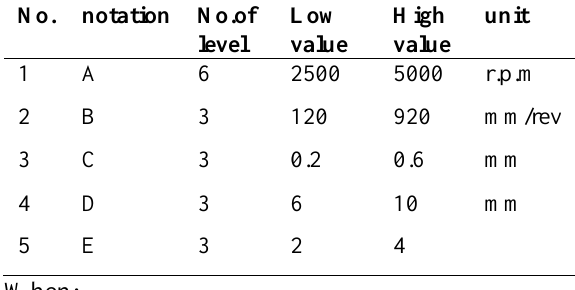
When: A: spindle Speed, B: feed rate, c: depth of cut D: diameter of cutter, E: number of flutes The roughness has been measured for two The roughness has been measured for two areas (convex and concave) of free form surface areas (convex and concave) of free form shown in Fig (4).